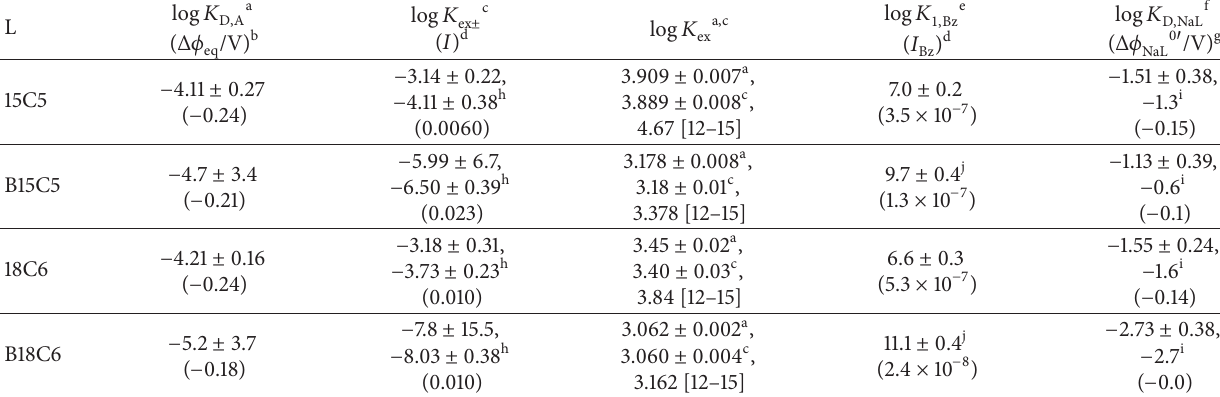
Table 1: Extraction data of the NaPic systems with L into Bz at 25 ∘